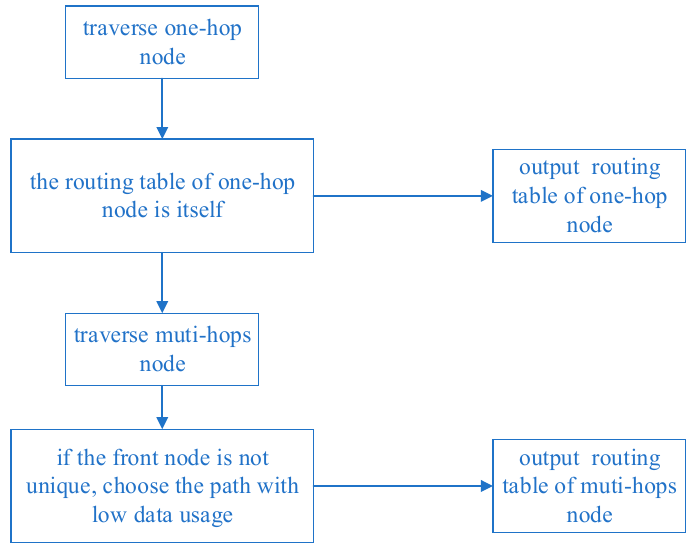
Figure 3. Multipath